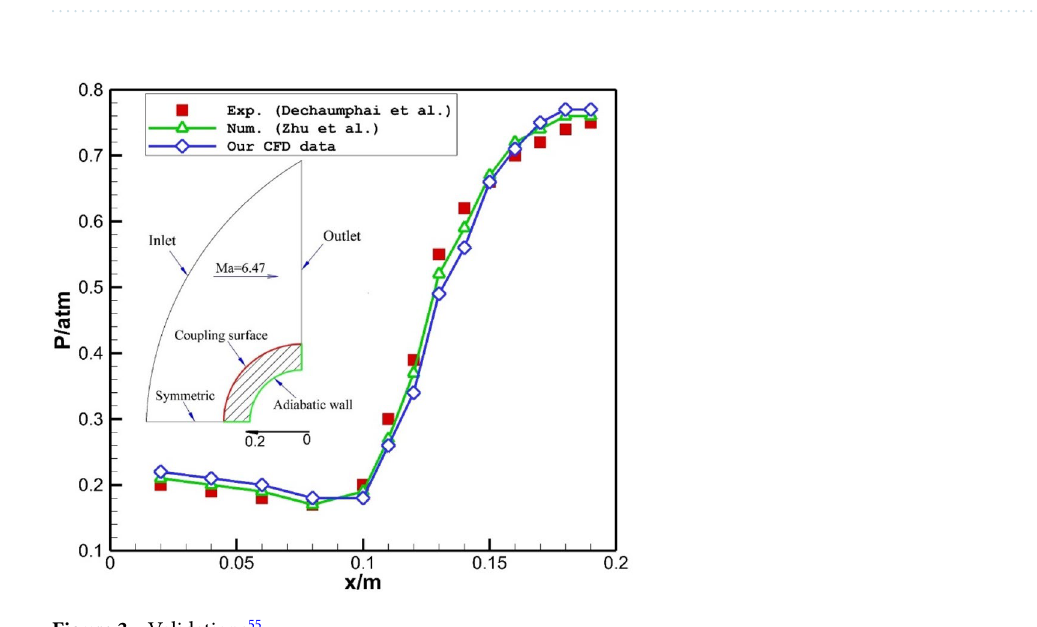
Figure 3. Validations 55